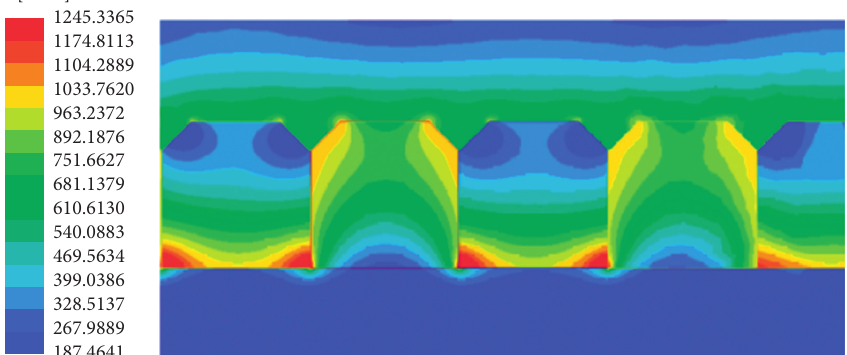
Figure 12: Cloud diagram of finite element of magnetic flux density of the CPMS.